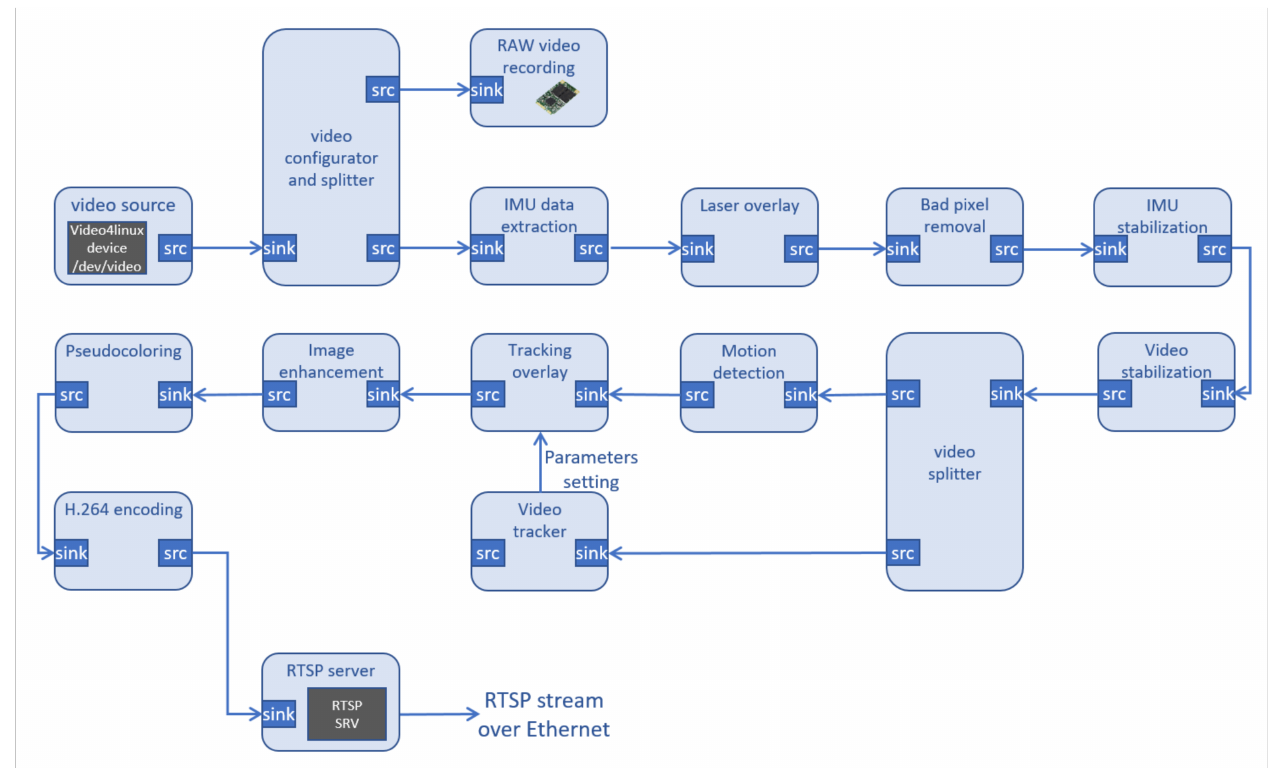
Figure 9. VVSP video processing